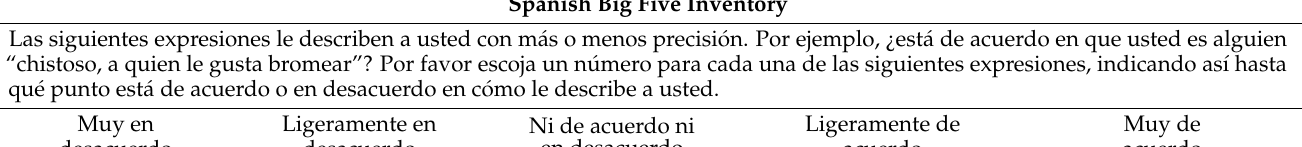
Table 1. Spanish and English Big Five Inventory. Spanish Big Five